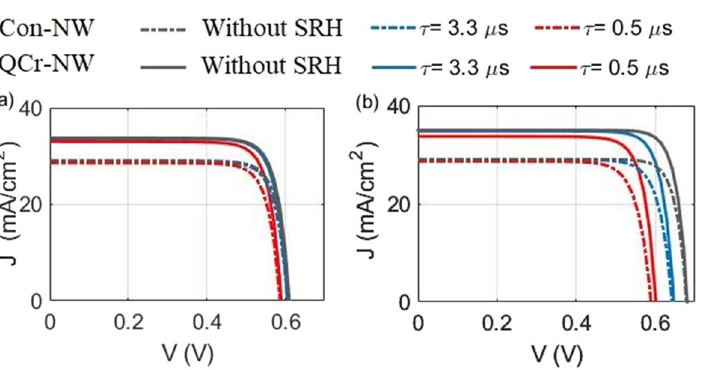
Figure 12. J–V electrical characteristics for both the studied designs in ( a ) the axial and ( b ) core–shell junctions at different lifetime